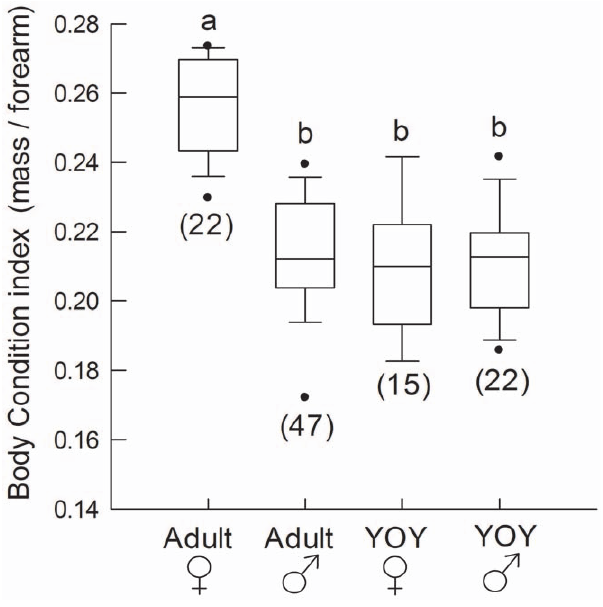
Figure 3. Body condition indices of bats during late hiberna- tion. Bats were captured on 27, 28 Apr 2009 in Iguana, Firecamp and Microwave caves. Numbers in brackets indicate sample size and boxes sharing the same letter are not significantly different from each other. Boxes depict the 25 th and 75 th percentiles, lines within boxes mark the median, whiskers represent 95 th and the 5 th percentiles and dots indicate outliers. doi:10.1371/journal.pone.0021061.g003 PLoS ONE |